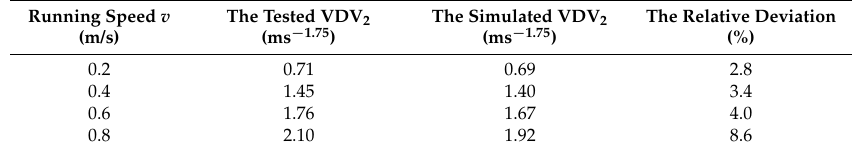
Table 4. The values of the parameters for the human-wheelchair system.